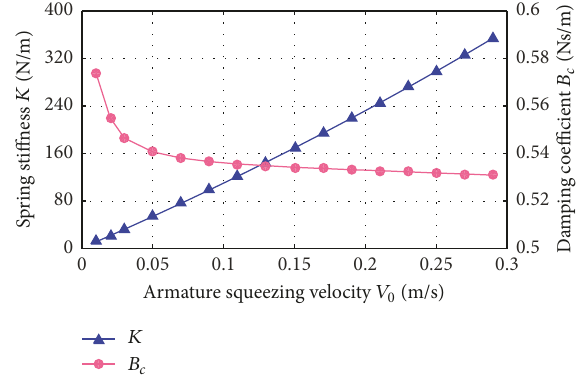
Figure 7: The spring stiffness and damping coefficient versus armature squeezing